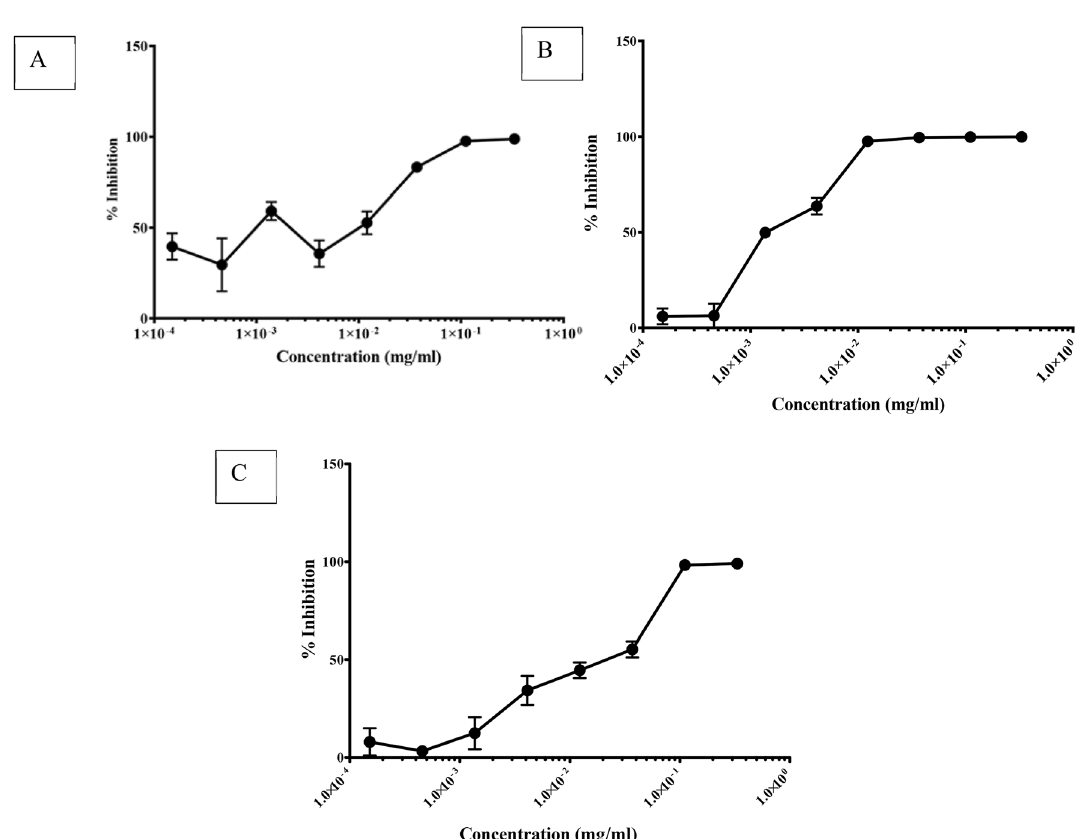
Figure 1. PHELA extract inhibition of SARS-CoV-2. ( A ) Wuhan strain, ( B ) a South African strain isolated during the first wave of the pandemic, and ( C ) the N501Y.V2 variant were incubated with the extract before infection of 293-T cells ACE.MF. After 72 h incubation the inhibition of infection was determined by measuring luminescence. Data shown represent the results of three independent experiments, and bars represent the means ± standard deviation.